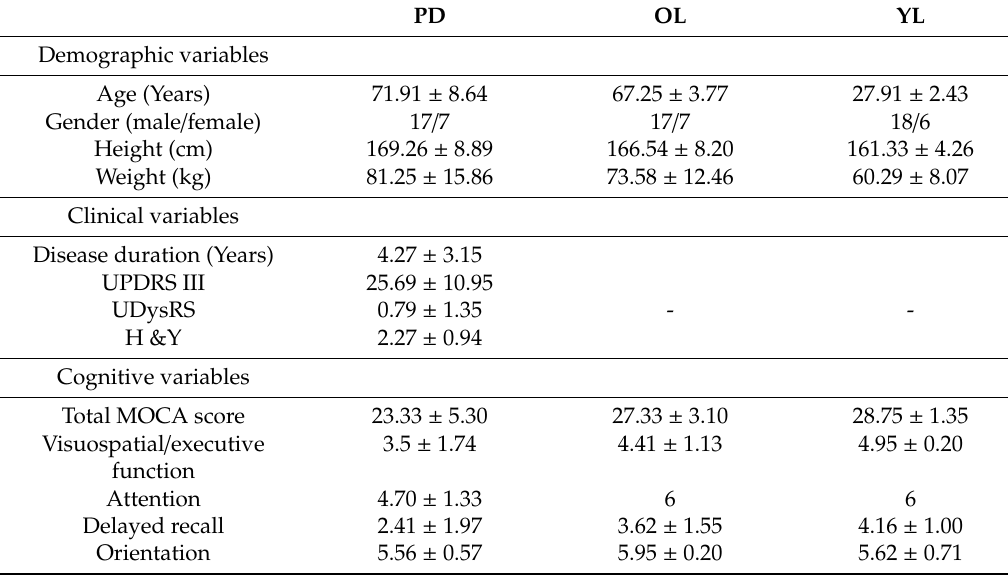
Table 1. The clinical characteristics in the mean (SD) of three groups–PD, OL,